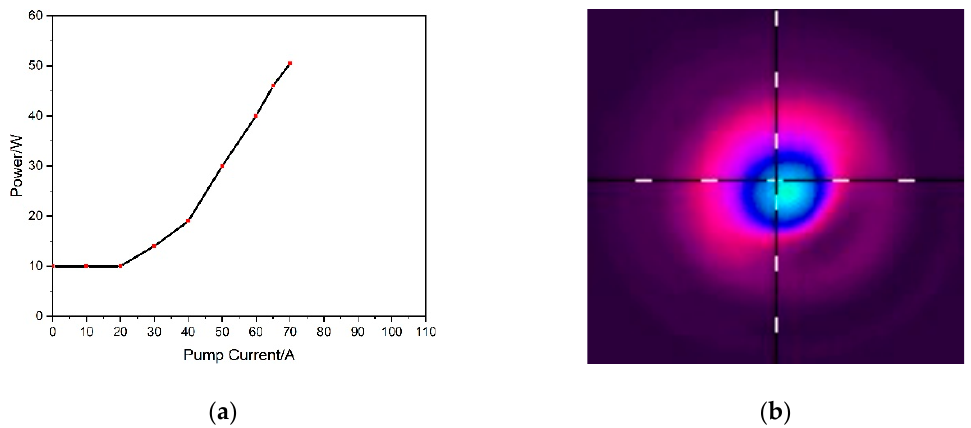
Figure 7. ( a ) Power curve of the side-pumped double-pass amplifier; ( b ) beam image of the side-pumped double-pass amplifier.